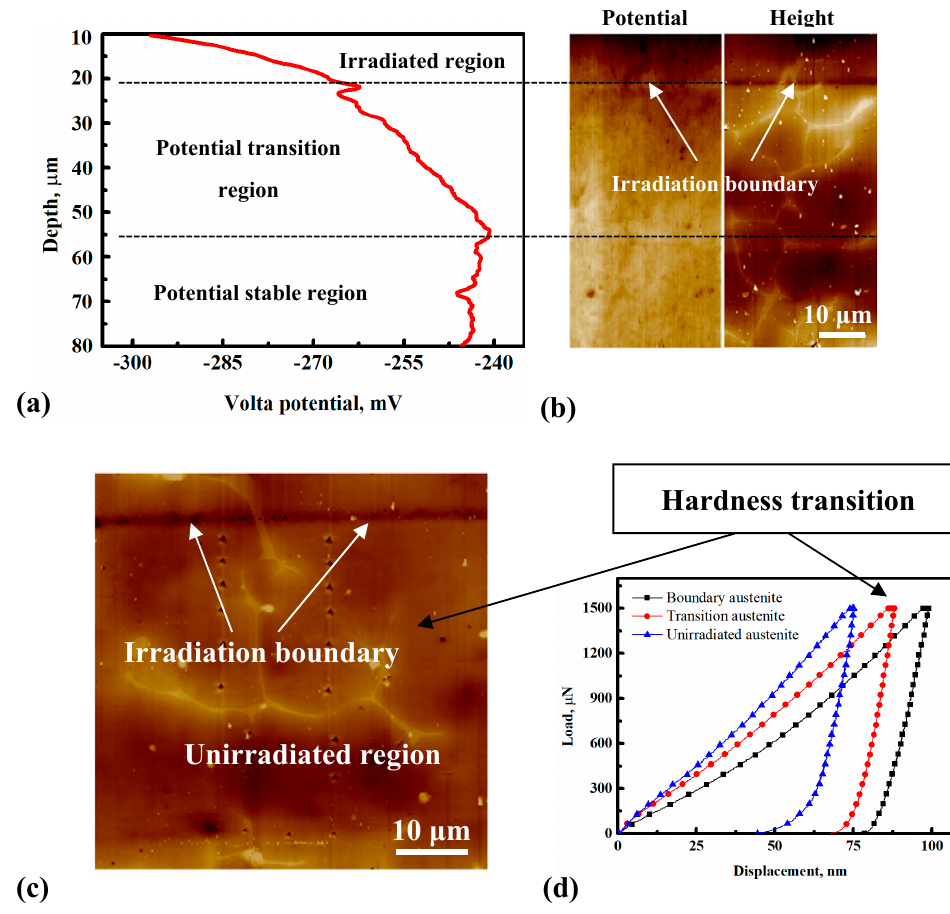
Figure 4. ( a ) The Volta potential curve vs. depth of the whole region shown in ( b ); ( b ) potential and topography height maps including irradiated (<20 µ m depth) and unirradiated region IV along the depth direction; ( c ) AFM image showing all indents in the austenite γ phase in irradiation boundary (region III) and unirradiated region IV; and ( d ) nanoindentation load-displacement curves of the austenite γ phase in the irradiation boundary (region III), potential transition, and stable potential regions (>55 µ m depth).